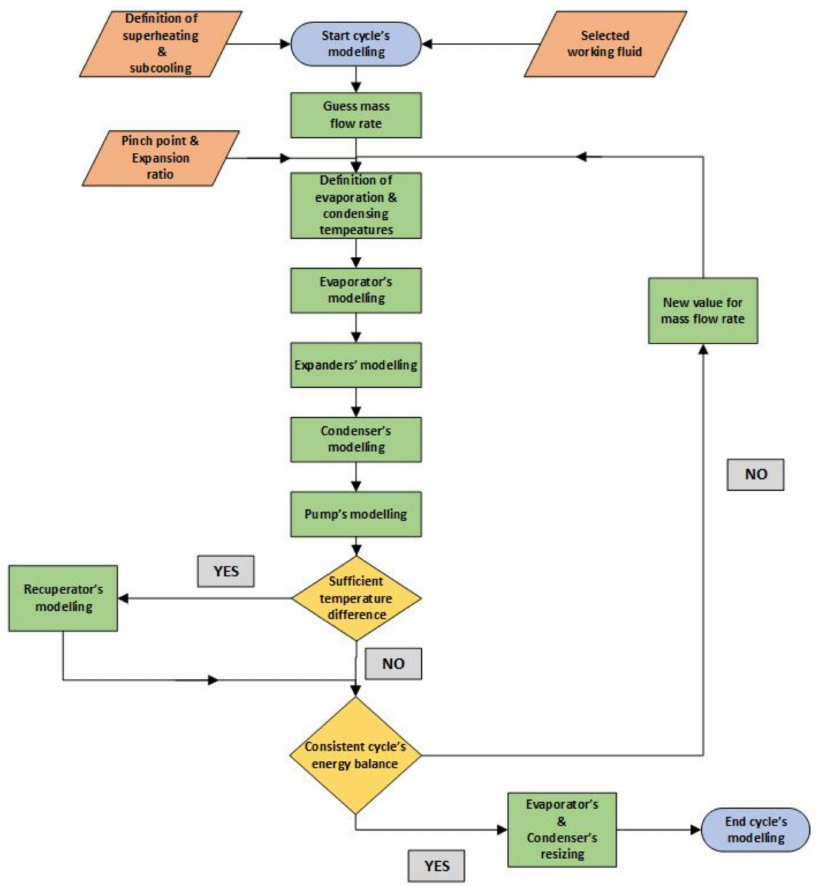
Figure A2. Flowchart of the ORC on-design modeling procedure.